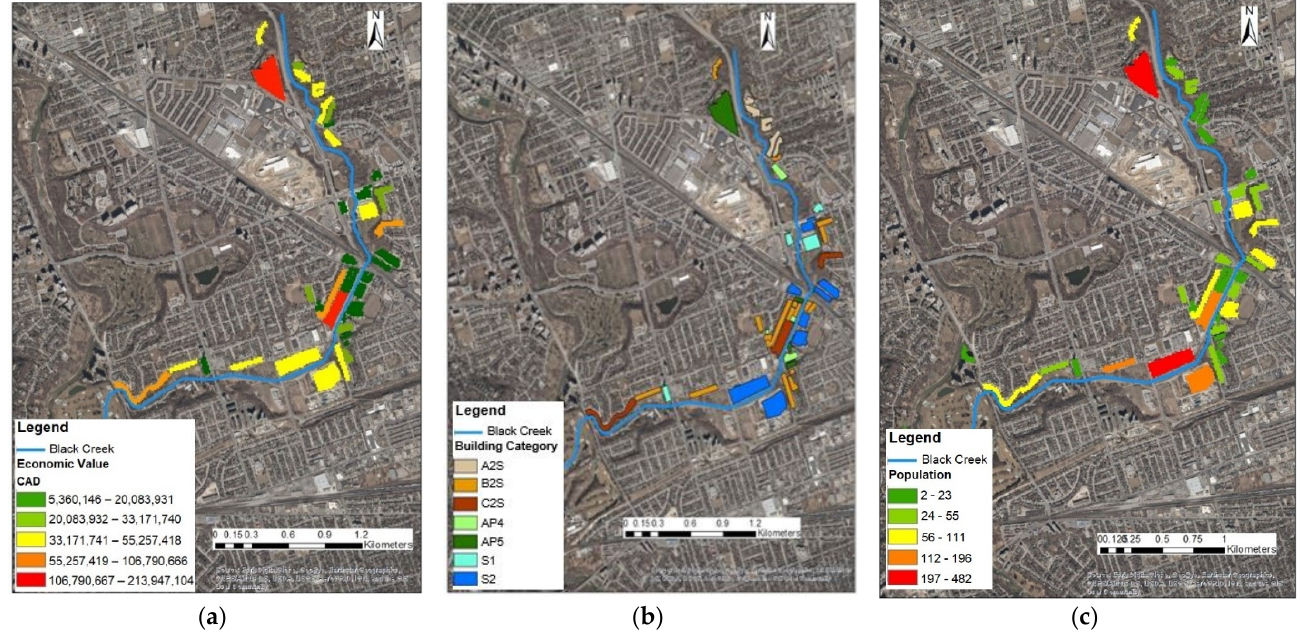
Figure 6. Exposure map classification: ( a ) economic value; ( b ) building category; ( c ) population. The direct damages were based only on the construction value per square meter obtained from the TRCA. The value of contents was not included. Table 2 shows the economic values used for each building category. For consistency, the economic values for the residential buildings were all assigned the same value of the category “House Class A—two floors” or A2S. Table 2. Economic values per building category.